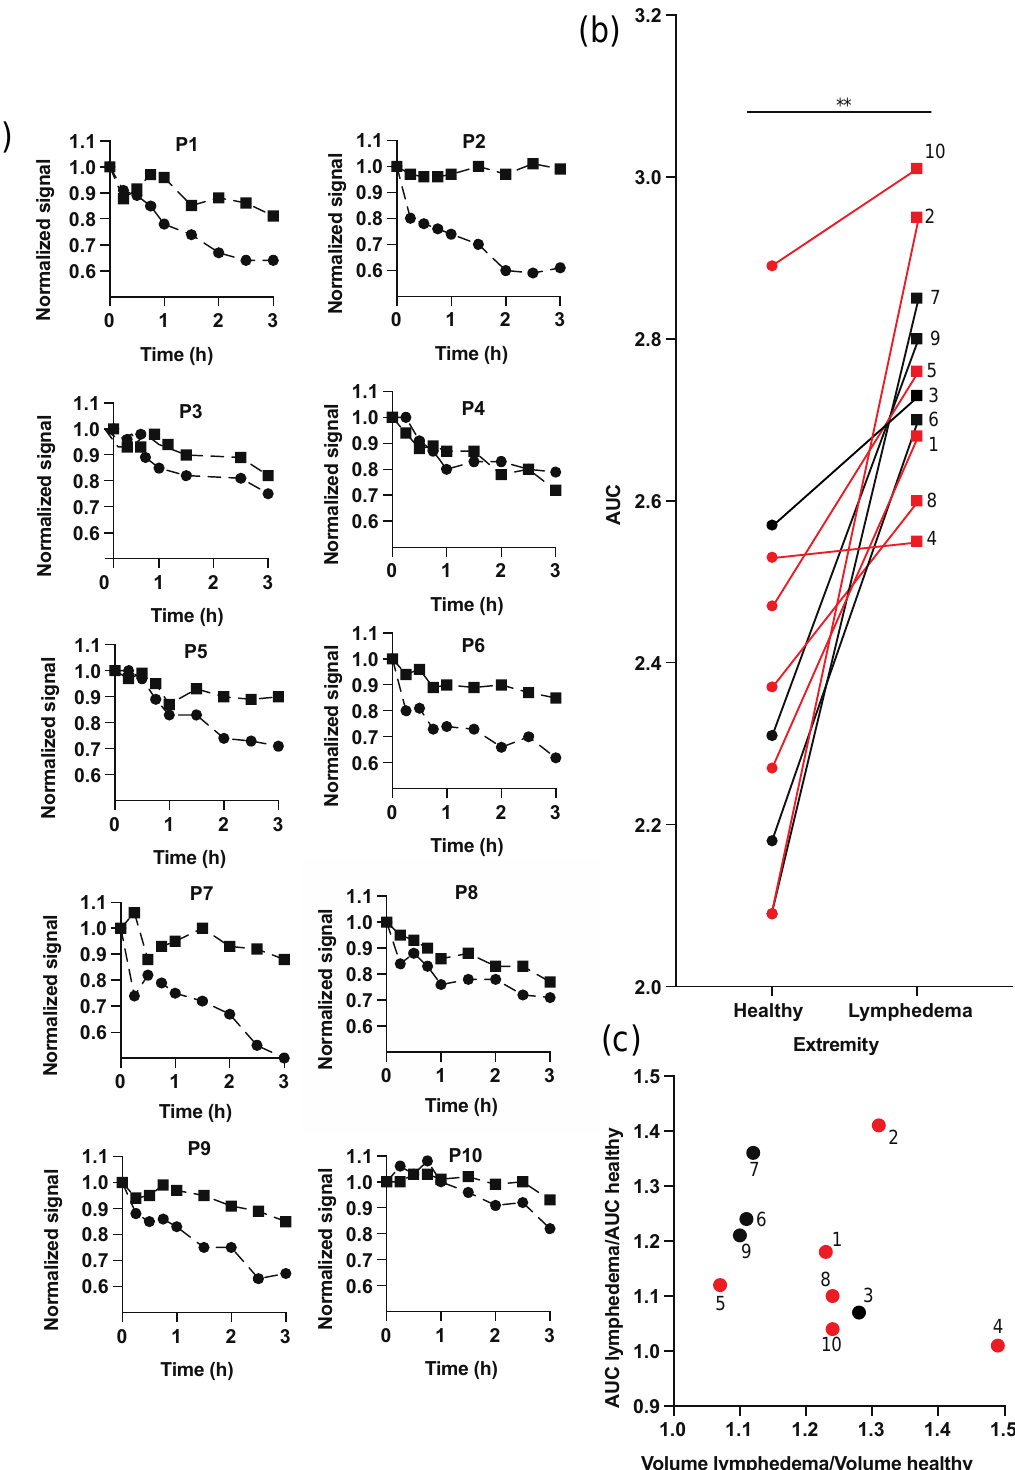
Figure 4. Lymphatic clearance measured by LymphMeter 1.0 in the skin of extremities of 10 patients after intradermal bolus administration of 50 µ L of ICG (0.0025 mg/mL) in a solution of 5% HSA using MicronJet600 TM microneedles. ( a ) Normalized clearance curves in lymphedematous (square) and contralateral healthy extremity (circle) for each patient. ( b ) AUCs for the lymphedema and the contralateral healthy extremity. Data were compared by Students t-test; ** p < 0.01. Data obtained in legs and arms are marked in red and black, respectively. ( c ) Correlation between ratios of AUCs and volumes in healthy and lymphedema extremities. r = − 0.3647 (Pearson’s correlation coefficient), p = 0.3001. Data obtained in legs and arms are marked in red and black,